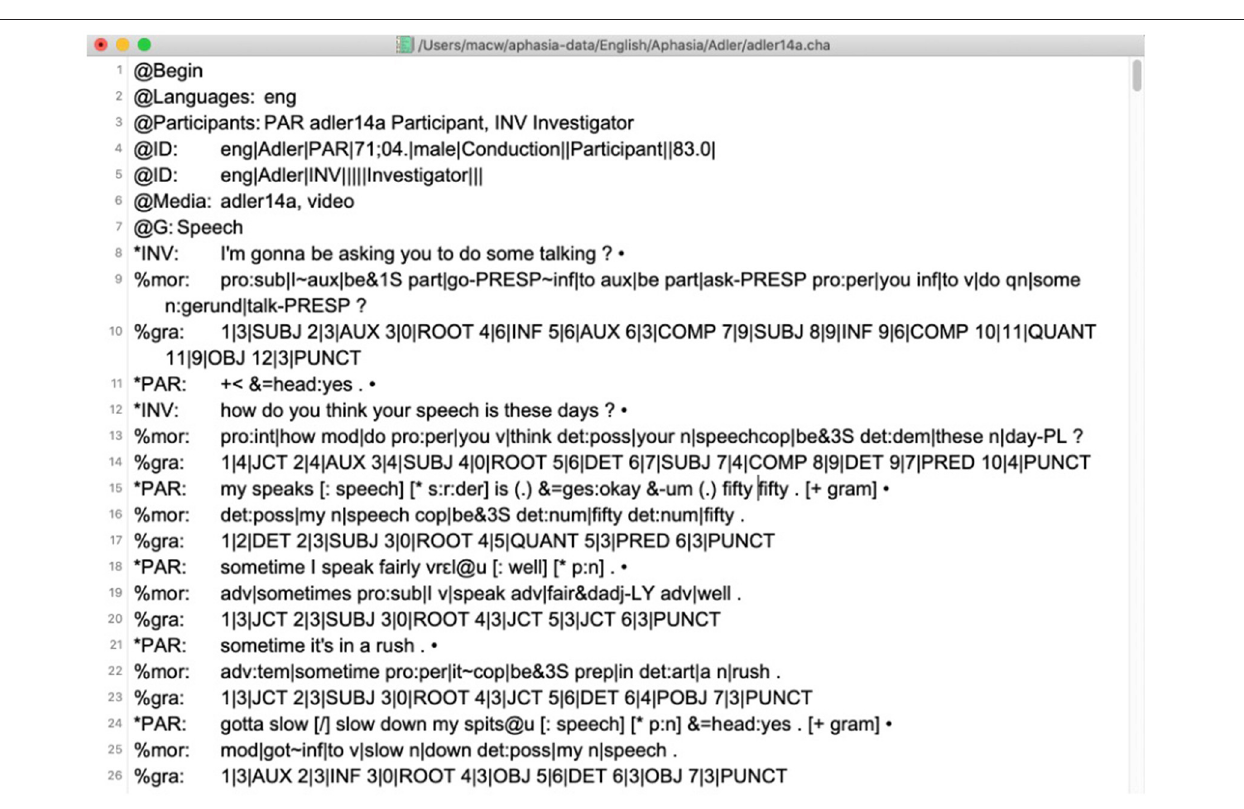
FIGURE 3 | An AphasiaBank transcript opened in the CLAN